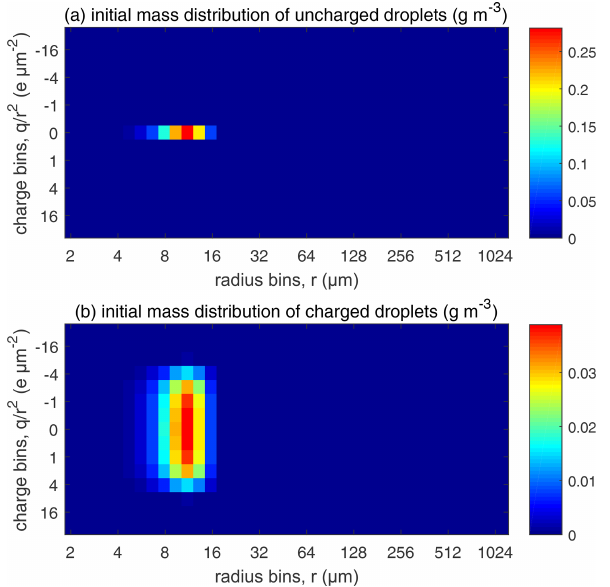
Figure 5. The initial droplet mass distributed over the size and charge bins. Colors represent water mass content in the bins (in units of gm − 3 ). (a) Uncharged droplets and (b) charged droplets.